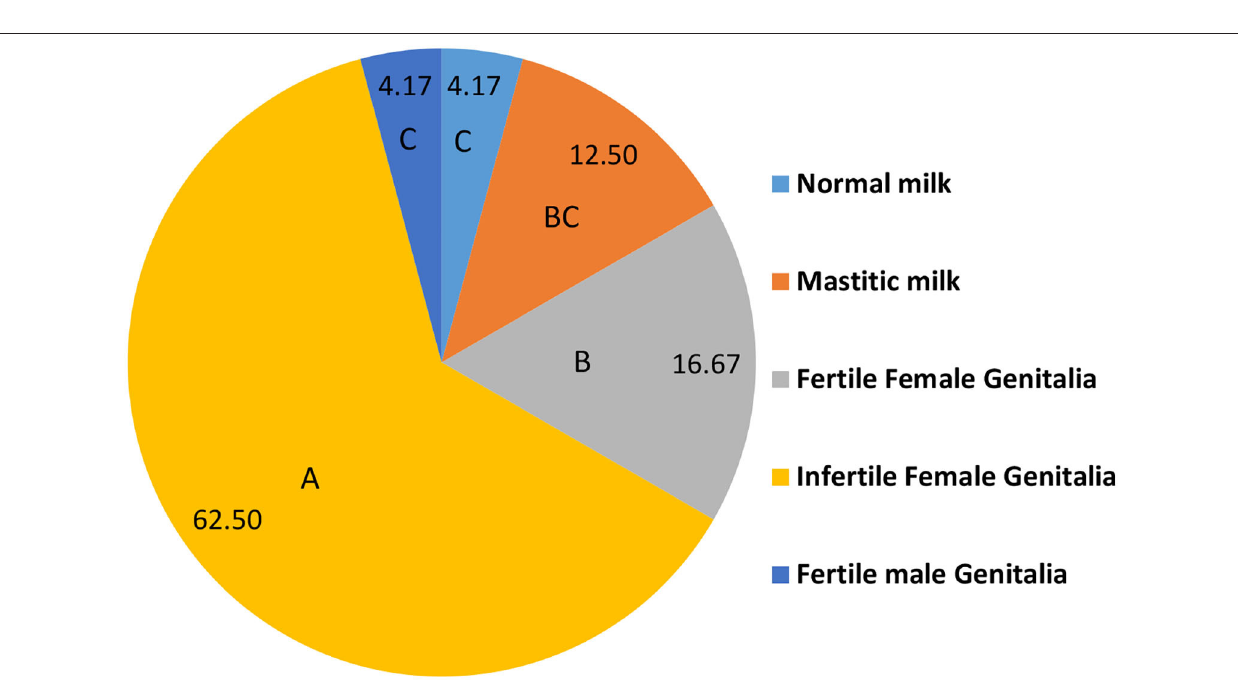
Frontiers in Veterinary Science |